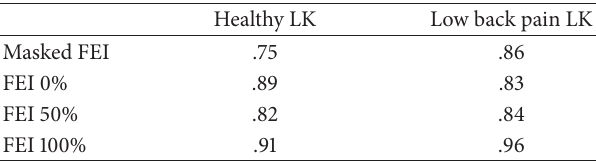
Table 1: Cronbach’s alphas related to clinicians’ answers per condi-